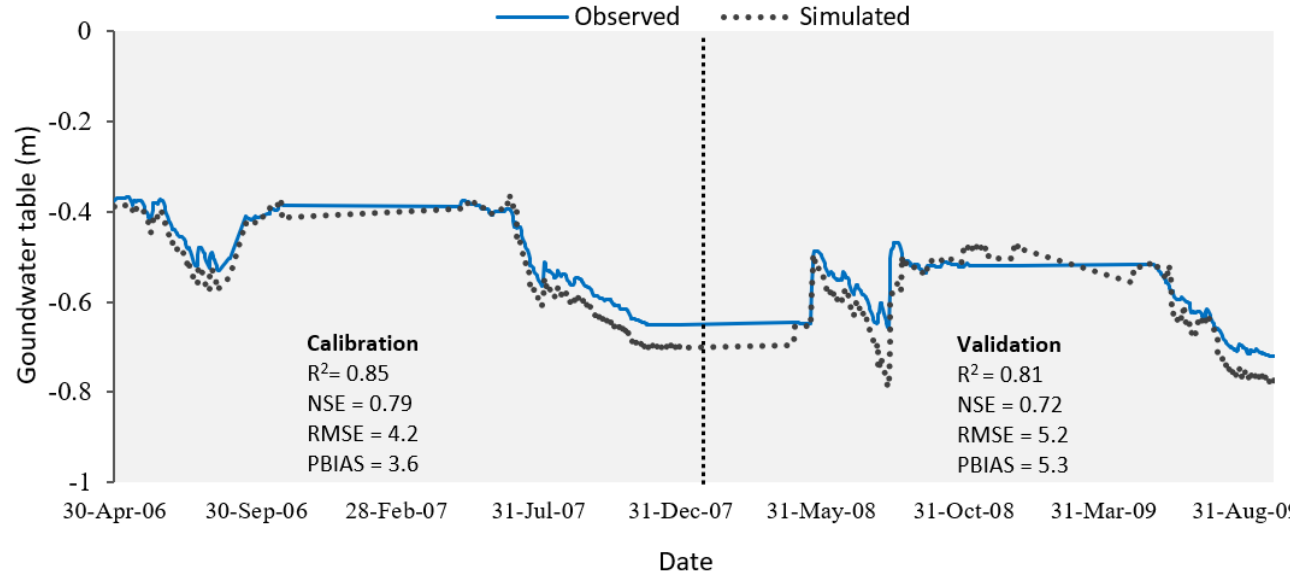
Figure 6. Observed and simulated daily groundwater table for the calibration and validation periods.